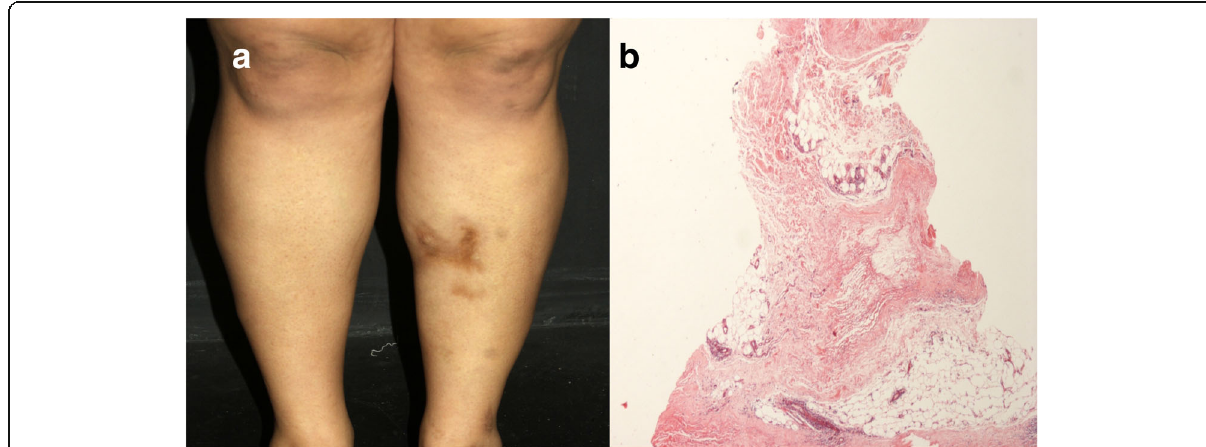
Fig. 4 Deep morphea. a Indurated plaque on the lower limb. b Thickening of the hypodermic septa by sclerotic collagen bundles, permeated by some lymphocytes and plasma cells, which extend to the periphery of the fat lobule. H&E,